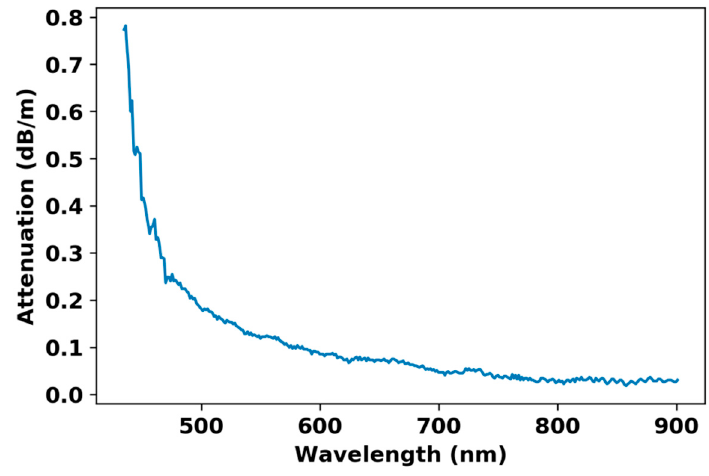
Figure 4. Attenuation spectrum of the tested Ce ‐ doped optical fiber.